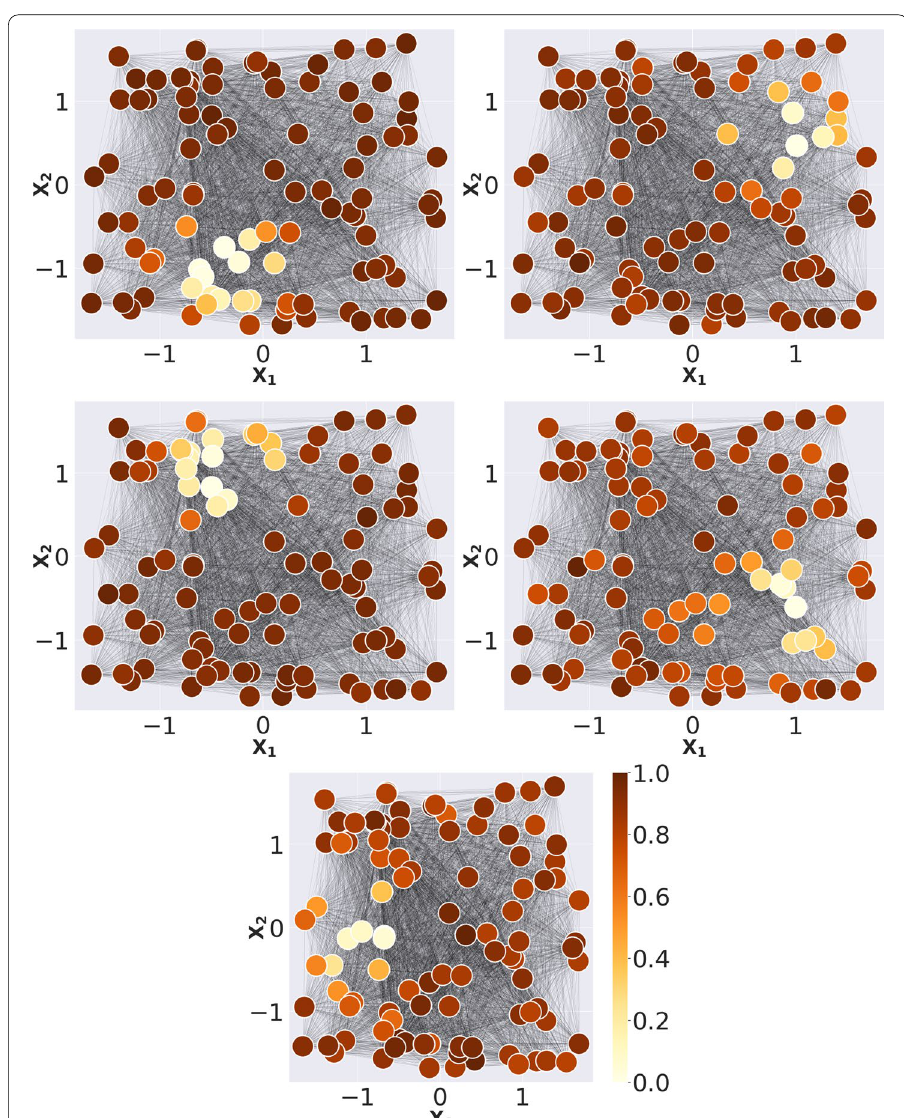
Vertices in brown have more edges than vertices in yellow and each state has a different cluster of vertices with fewer edges. Thus, the state-dependent graph exhibits a unique topology making it